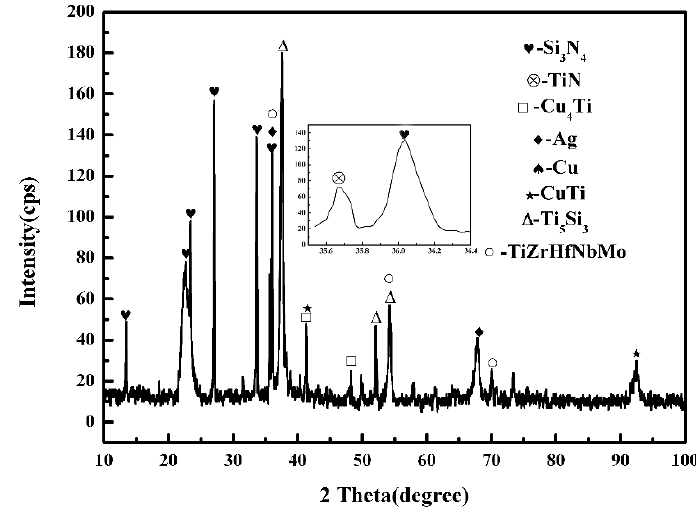
Figure 3. XRD pattern of brazed joint at 840 °C for 60 min.